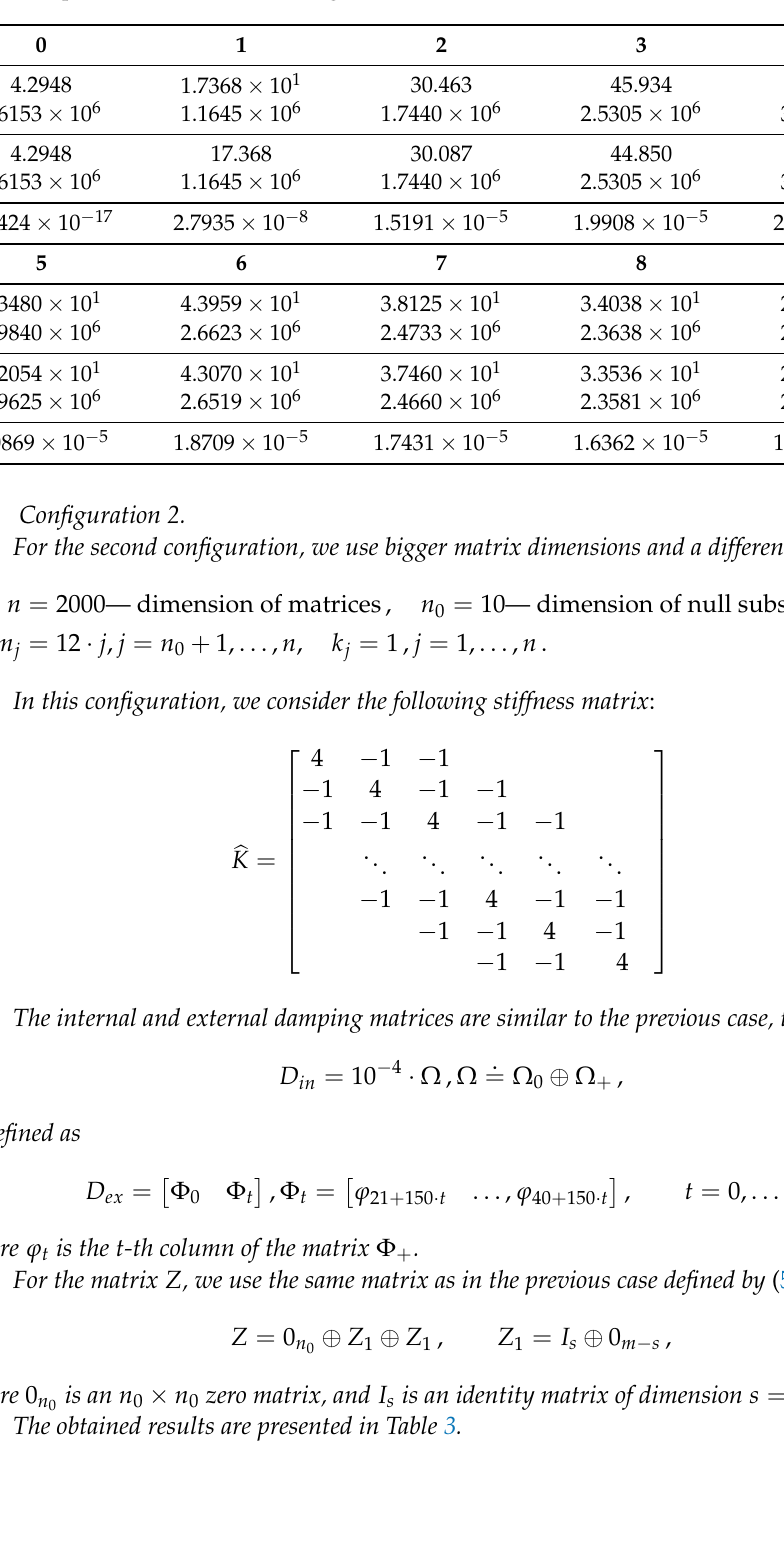
Table 2. Optimal viscosities for Configuration